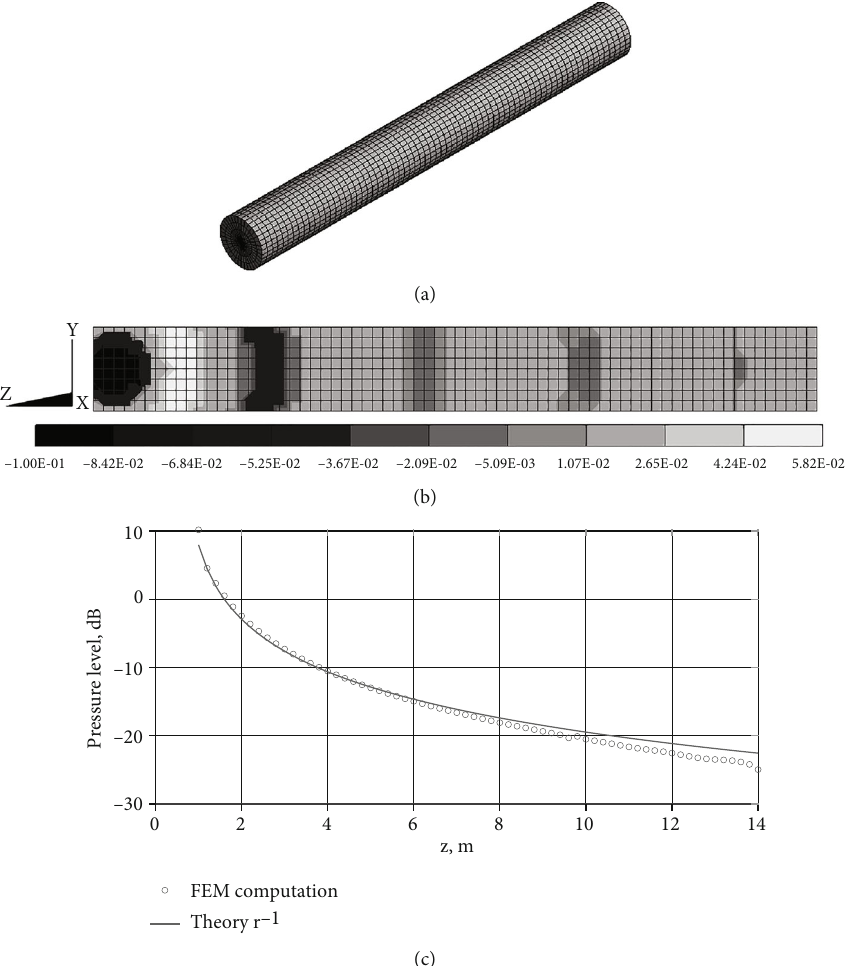
Figure 4: The result of calculations based on a model consisting of the SE of the cylindrical volume of the medium, the modeled FE (a), and the boundary super-element. The point source is located in the medium. The pressure modulus in dB at the points on the cylinder axis (b) and the instantaneous pressure value in the YZ plane (c) are shown. The frequency is 500 Hz and the mesh step is 0.1m; cylindrical volume dimensions: diameter 1.6m and length 14